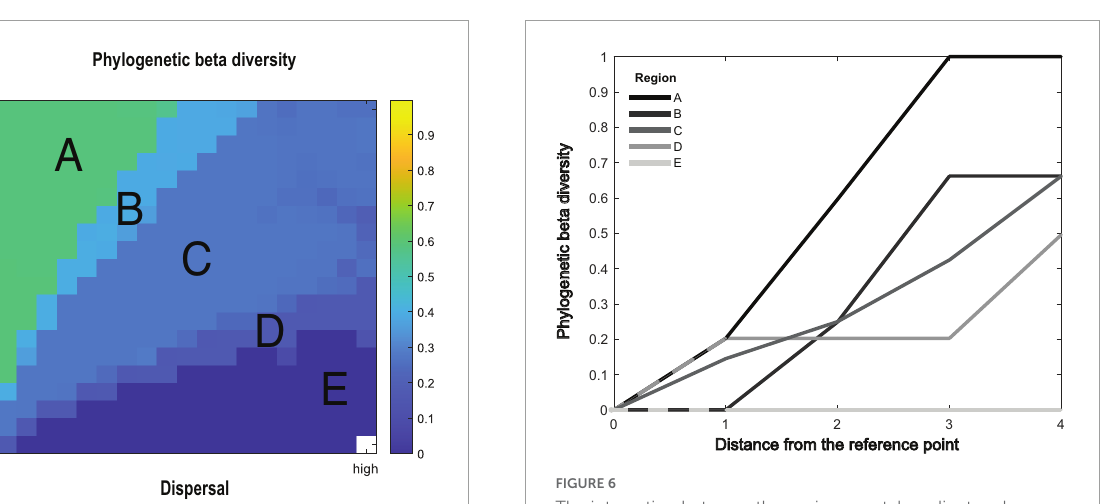
Distance from the reference point FIGURE6 The interaction between the environmental gradient and dispersal affects how phylogenetic beta diversity (PBD) increases with geographical distance from the reference point. When the environmental gradient is steep and dispersal is low, PBD increases almost linearly with the geographical distance. When dispersal increases, the PBD within a short distance decreases rapidly. When the environmental gradient is low and dispersal is high, PBD does not have a linear relationship with the geographical distance. PBD is plotted with dispersal = 0.04 and across environmental gradient (A: (cid:49) u opt = 0 . 95 σ u ; B: (cid:49) u opt = 0 . 86 σ u ; C: (cid:49) u opt = 0 . 52 σ u ; D: (cid:49) u opt = 0 . 29 σ u ; E: (cid:49) u opt = 0 . 19 σ u ), overlapping lines are presented as dashed lines.